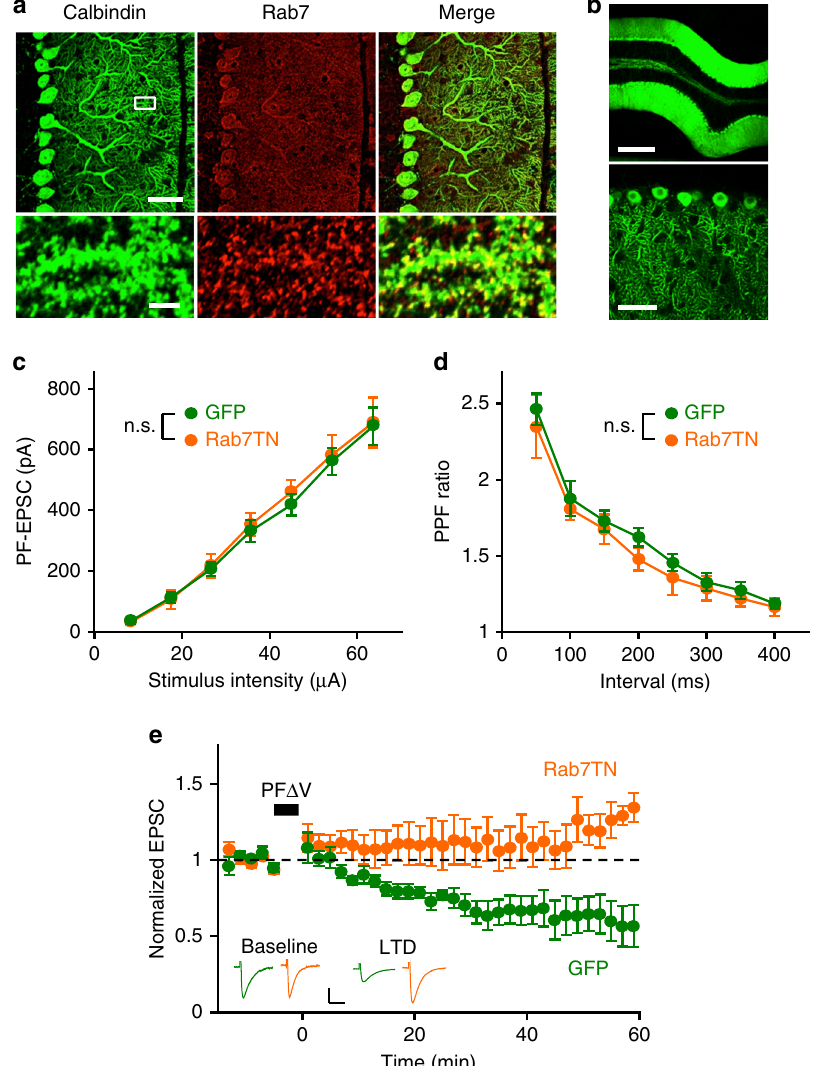
Fig. 3 Rab7-dependent LE sorting is involved in LTD. a Confocal images of a cerebellar slice double stained with antibodies against calbindin ( green ) and Rab7 ( red ). Scale bars : top , 40 μ m; bottom , 4 μ m. The area within the white square is magni fi ed in the lower panels. b Images of a cerebellar slice expressing GFP-Rab7TN in PCs. Scale bars : top , 300 μ m; bottom , 50 μ m. c Amplitudes of PF-EPSCs elicited by PF stimuli of increasing intensity (8.2, 17.4, 26.5, 35.6, 44.9, 54.2, and 63.6 μ A), which were recorded from PCs expressing GFP alone ( green circles , n = 10), or GFP-Rab7TN ( orange circles , n = 6). d Paired pulse facilitation ( PPF ) ratios of PF-EPSCs elicited by a pair of PF stimuli with different intervals (50 – 400ms) from PCs expressing GFP alone ( green circles , n = 13), or GFP-Rab7TN ( orange circles , n = 12). e Time course of LTD induced by PF Δ V in PCs expressing GFP alone ( green circles , n = 9), or